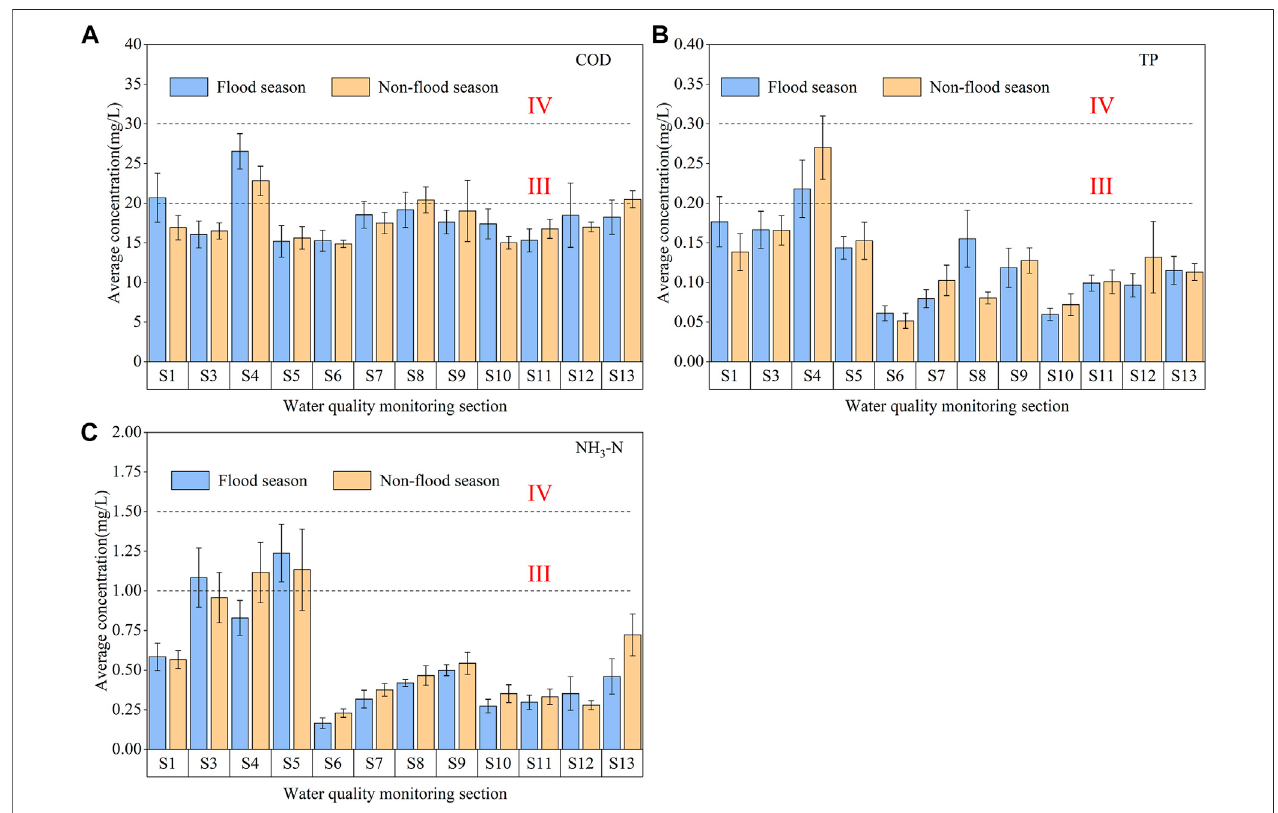
FIGURE3| Averageconcentrationsand statisticallysigni fi cantdifferences ofwaterquality parameters at monitoring sections inthe differentseasons from 2017to 2019 (One-way ANOVA, p ≤ 0.01; GR Basin: S1-S5; SR Basin: S6-S11; BR Basin: S12-S13, (A) COD, (B) TP, (C) NH 3 -N).